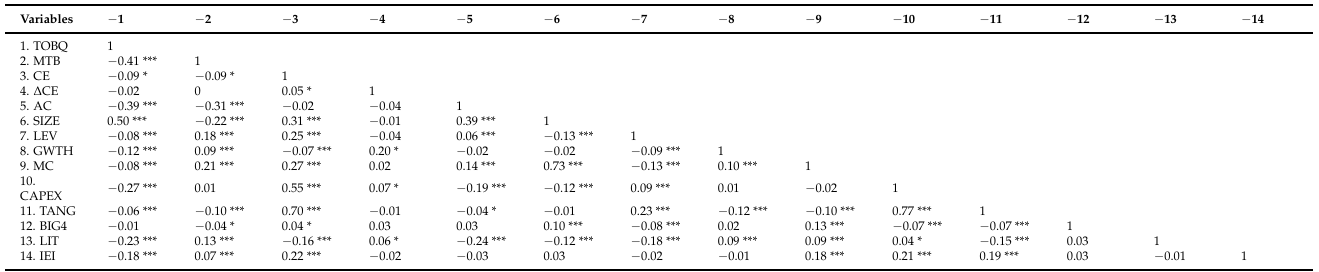
Table 3. Pearson correlation